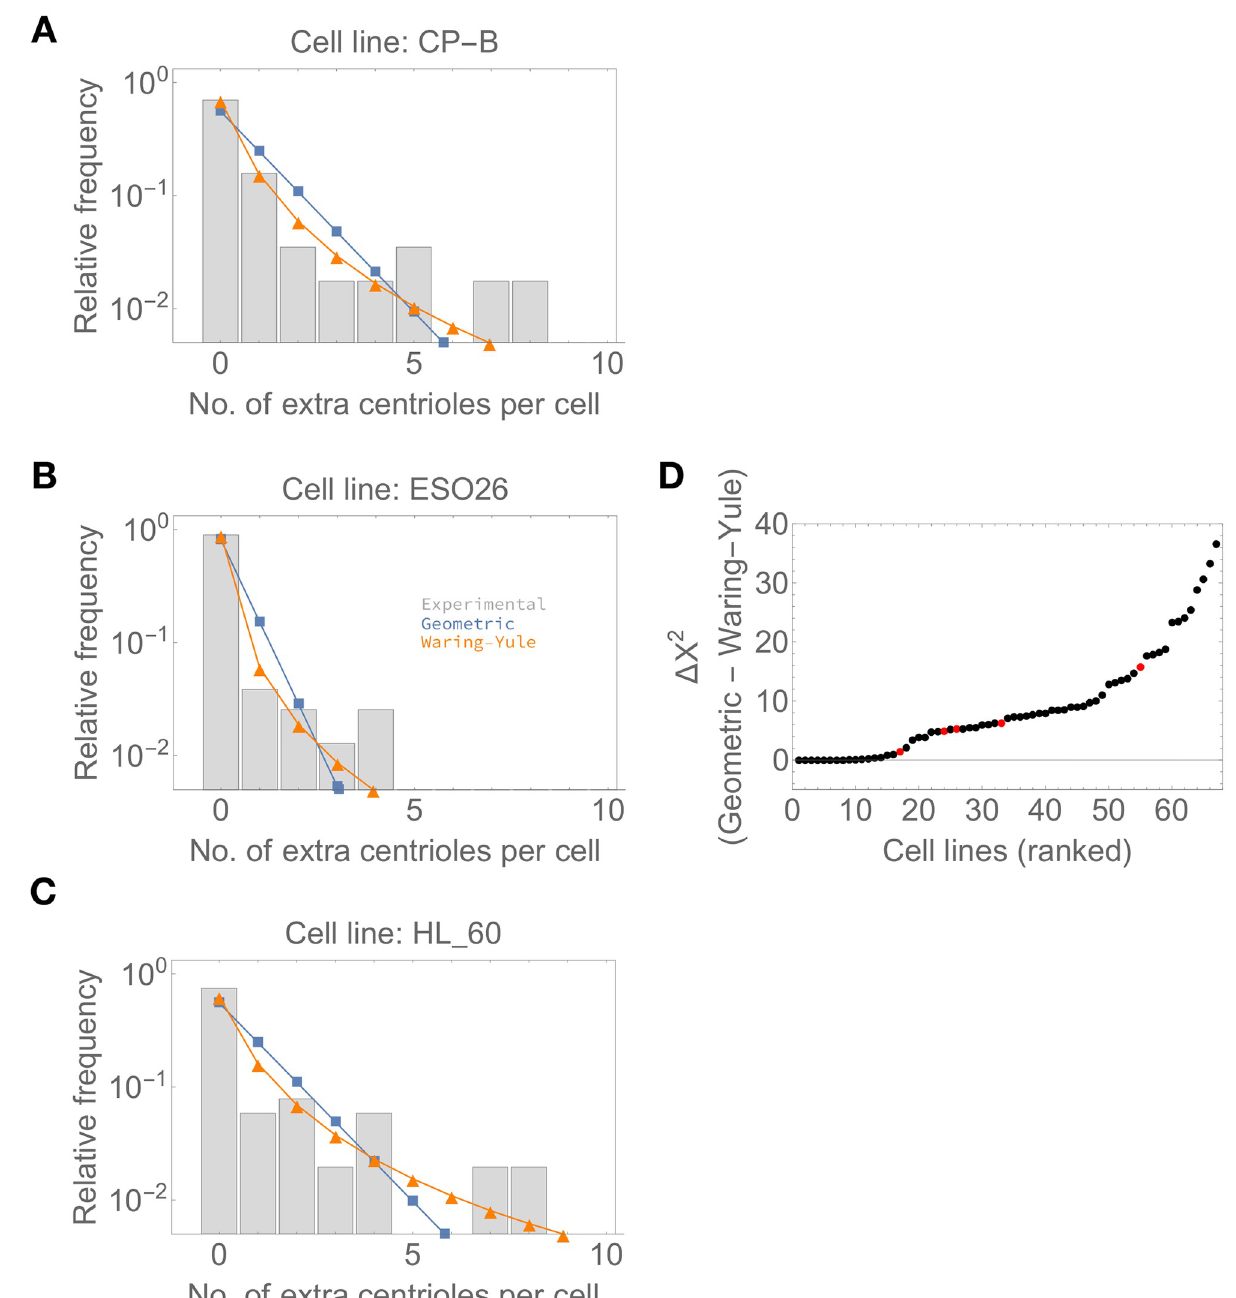
Fig 1. Distributions of centriole numbers in cell populations tend to be heavy-tailed. A-C—Examples of empirical distributions for three cell lines (grey bars) and the predicted relative frequencies under geometric (blue) and Waring-Yule distributions (orange), which are representative of distributions with exponential-like and heavy tails, respectively. Number of sampled cells: (A) n = 57; (B) n = 78; (C) n = 51. D—Difference between the calculated X 2 value under geometric and Waring-Yule distributions. Cell lines were ranked in ascending order according to the Δ X 2 value. The control cell lines used in [10] are highlighted in red. Higher positive values indicate a better fit of the Waring-Yule distribution to the corresponding empirical distribution, suggesting heavier-than-exponential tails.